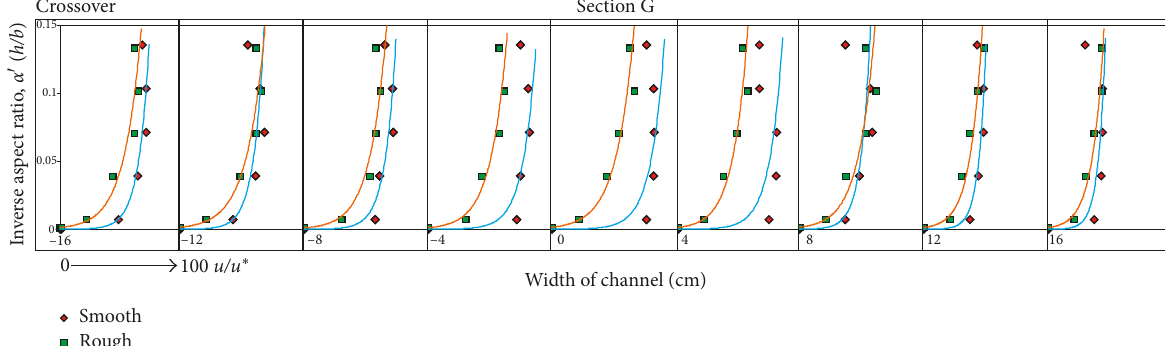
Figure 10: Comparison of velocity variation in section G.